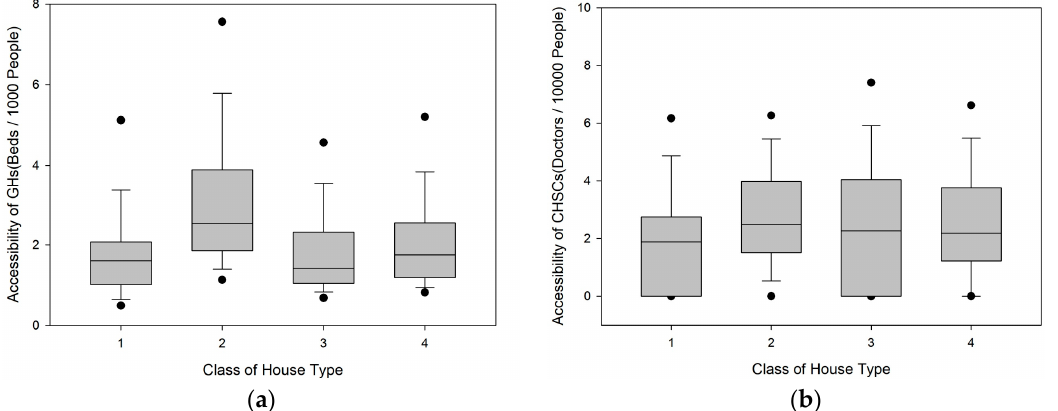
Figure 4. Box-plots of the accessibility for different classes of living house type. ( a ) Box-plots of the accessibility of GHs; ( b ) Box-plots of the accessibility of CHSCs.